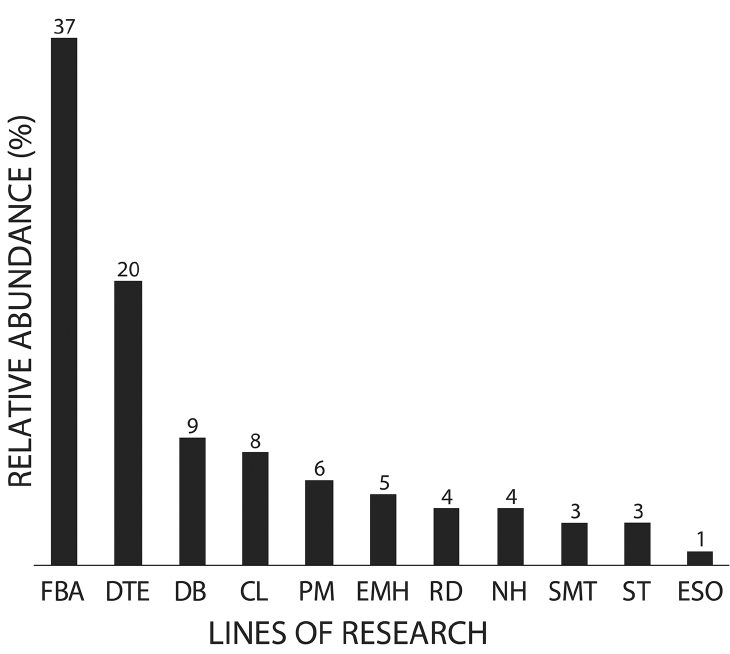
Figure 1. Relationship between different lines of investigation: (FBA) Faunistics, Biodiversity, and Abundance, (DTE) Diet and Trophic Ecology, (DB) Distribution and Biogeography, (CL) Conservation and Legislation, (PM) Parasitology and Medicine, (EMH) Ethology, Migration, and Home environment, (RD) Reproduction and Development, (NH) Natural History, (SMT) Study Methods and Techniques, (ST) Systematics and Taxonomy, and (ESO) Environmental Education and Science